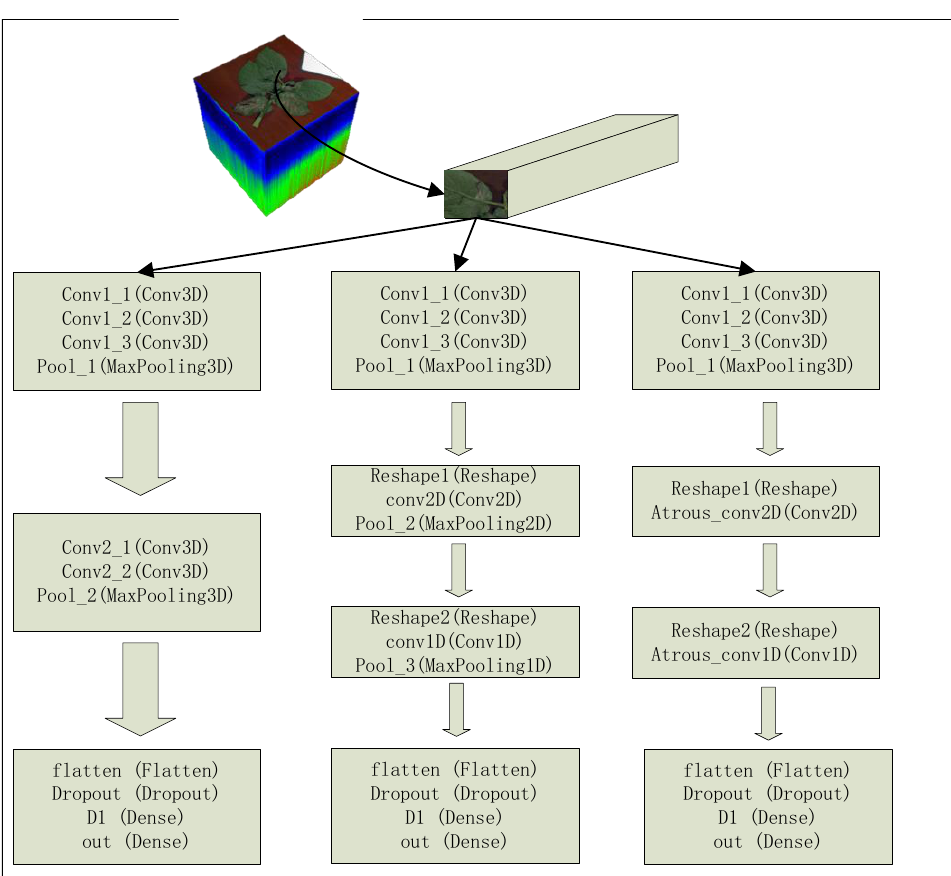
Figure 5. Comparison of three CNN